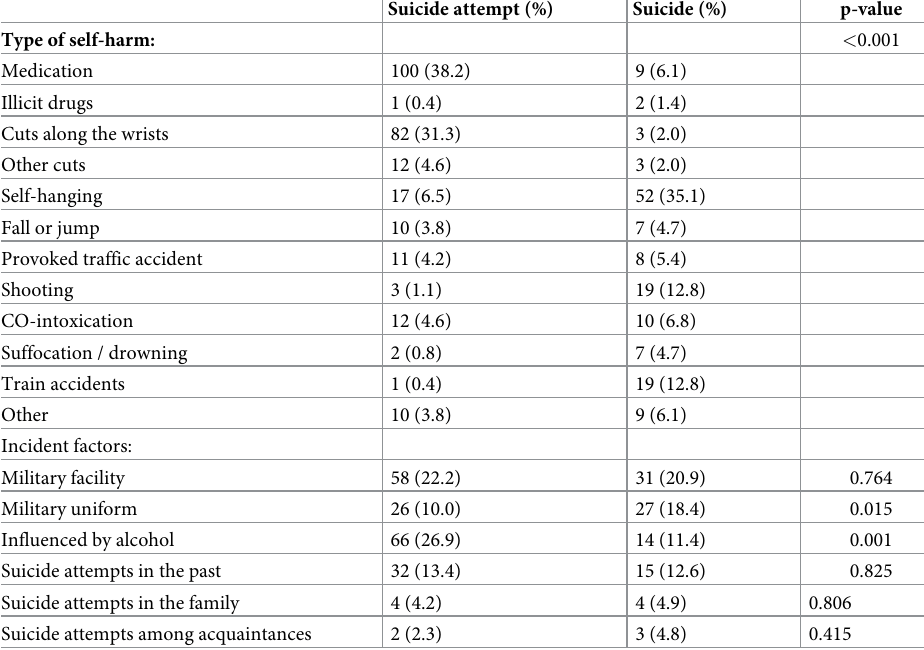
Table 5. Suicide methods and accompanying incident factors.